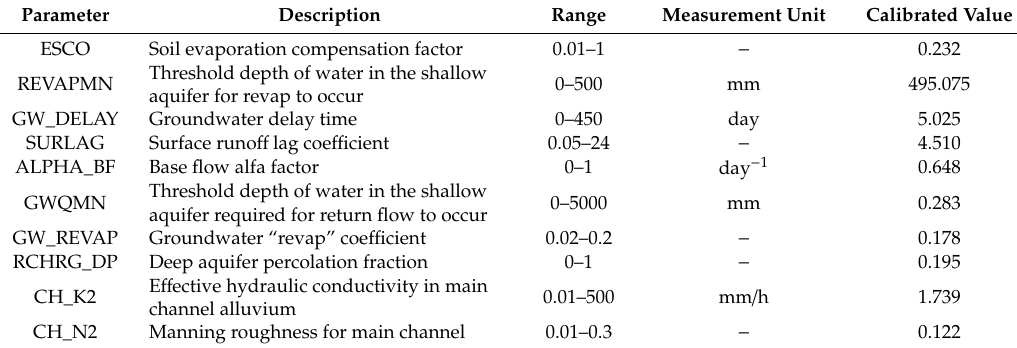
Table 1. Ranges for model calibration and final value of Soil and Water Assessment Tool (SWAT) parameters (ordered from the most sensitive to the